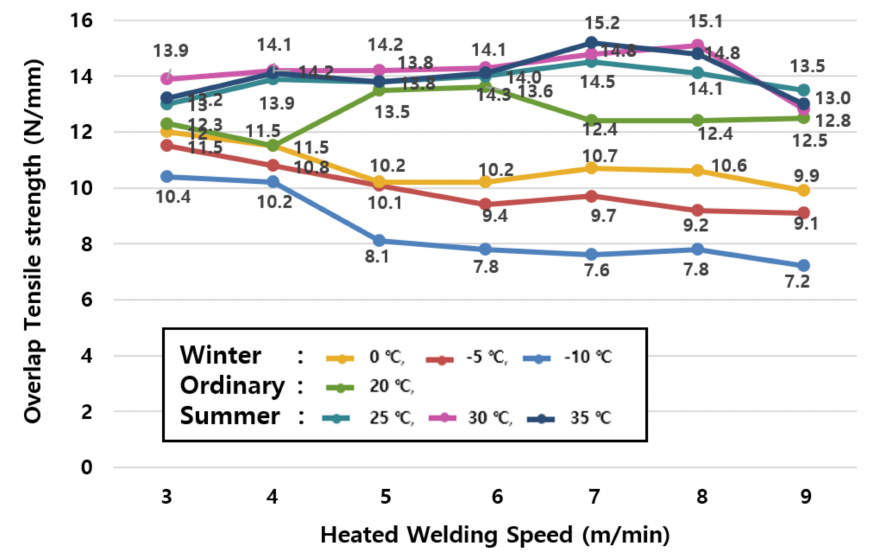
Figure 10. Tensile strength test results according to the joint construction temperature.